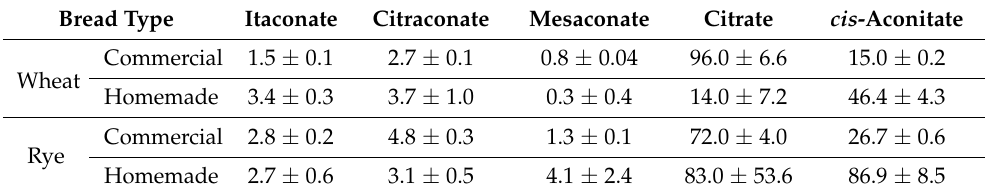
Table 1. Comparison of calculated amounts of all analytes per slice of bread (g × 10 − 6 ± SD). Bread